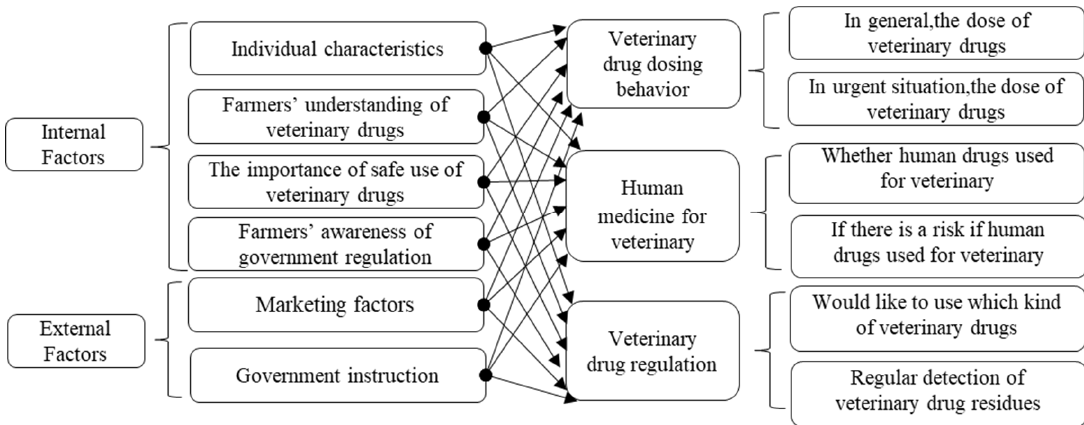
Figure 1. Behavioral model of safe veterinary drug use by farmers.